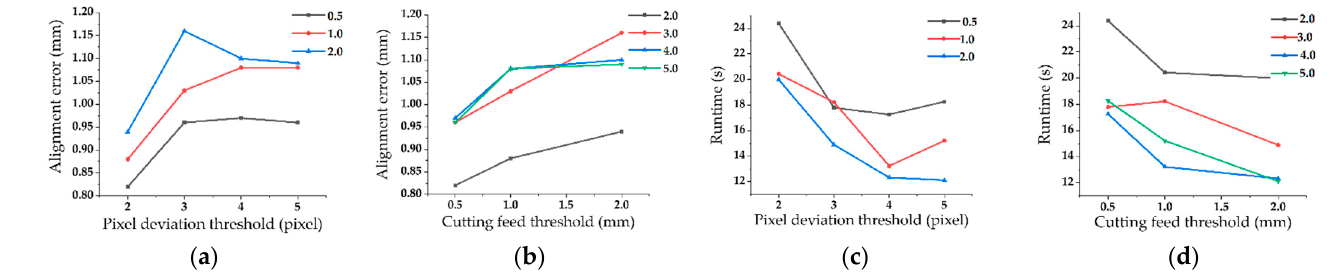
Figure 9. Curves of multiple threshold pair test results: ( a ) pixel deviation—alignment error results, ( b ) cutting feed—alignment error results, ( c ) pixel deviation—execution results, and ( d ) cutting feed—execution results [18].